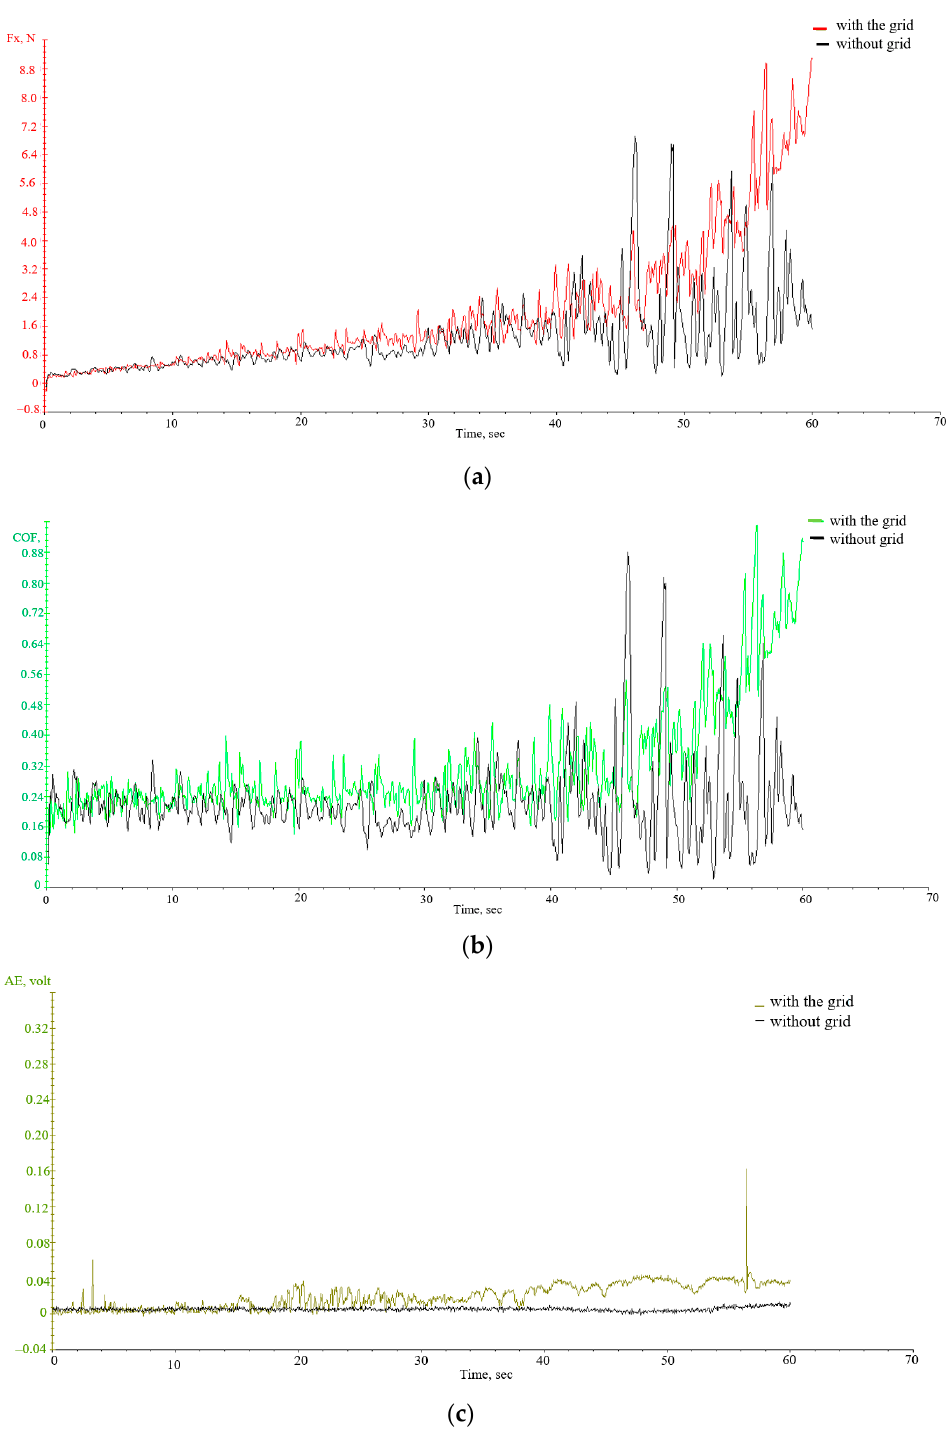
Figure 15. Time variation of Fx ( a ), COF ( b ), and AE ( c ) during the scratch test for both cases of nitriding (with and without grid).